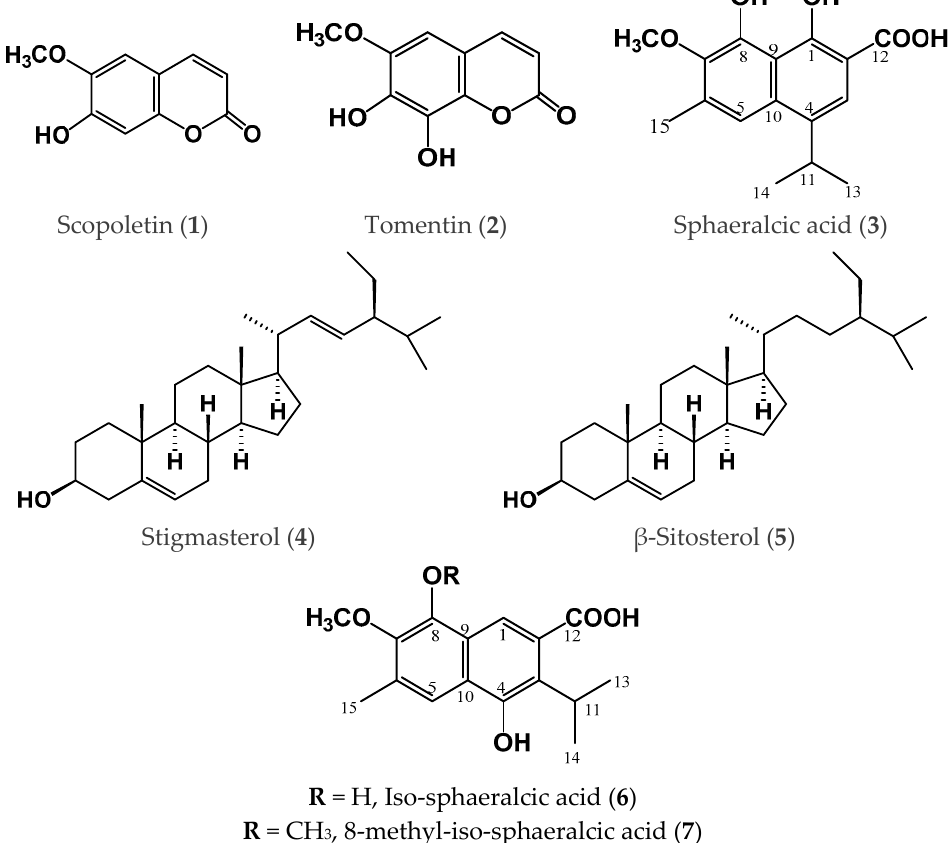
Figure 1. Compounds isolated from wild plants and cells in a suspension of S. angustifolia and identified in the dichloromethane–methanol extracts of the SaTRN12.2 (line 1) and SaTRN 7.1 (line 2) hairy root lines of Sphaeralcea angustifolia.